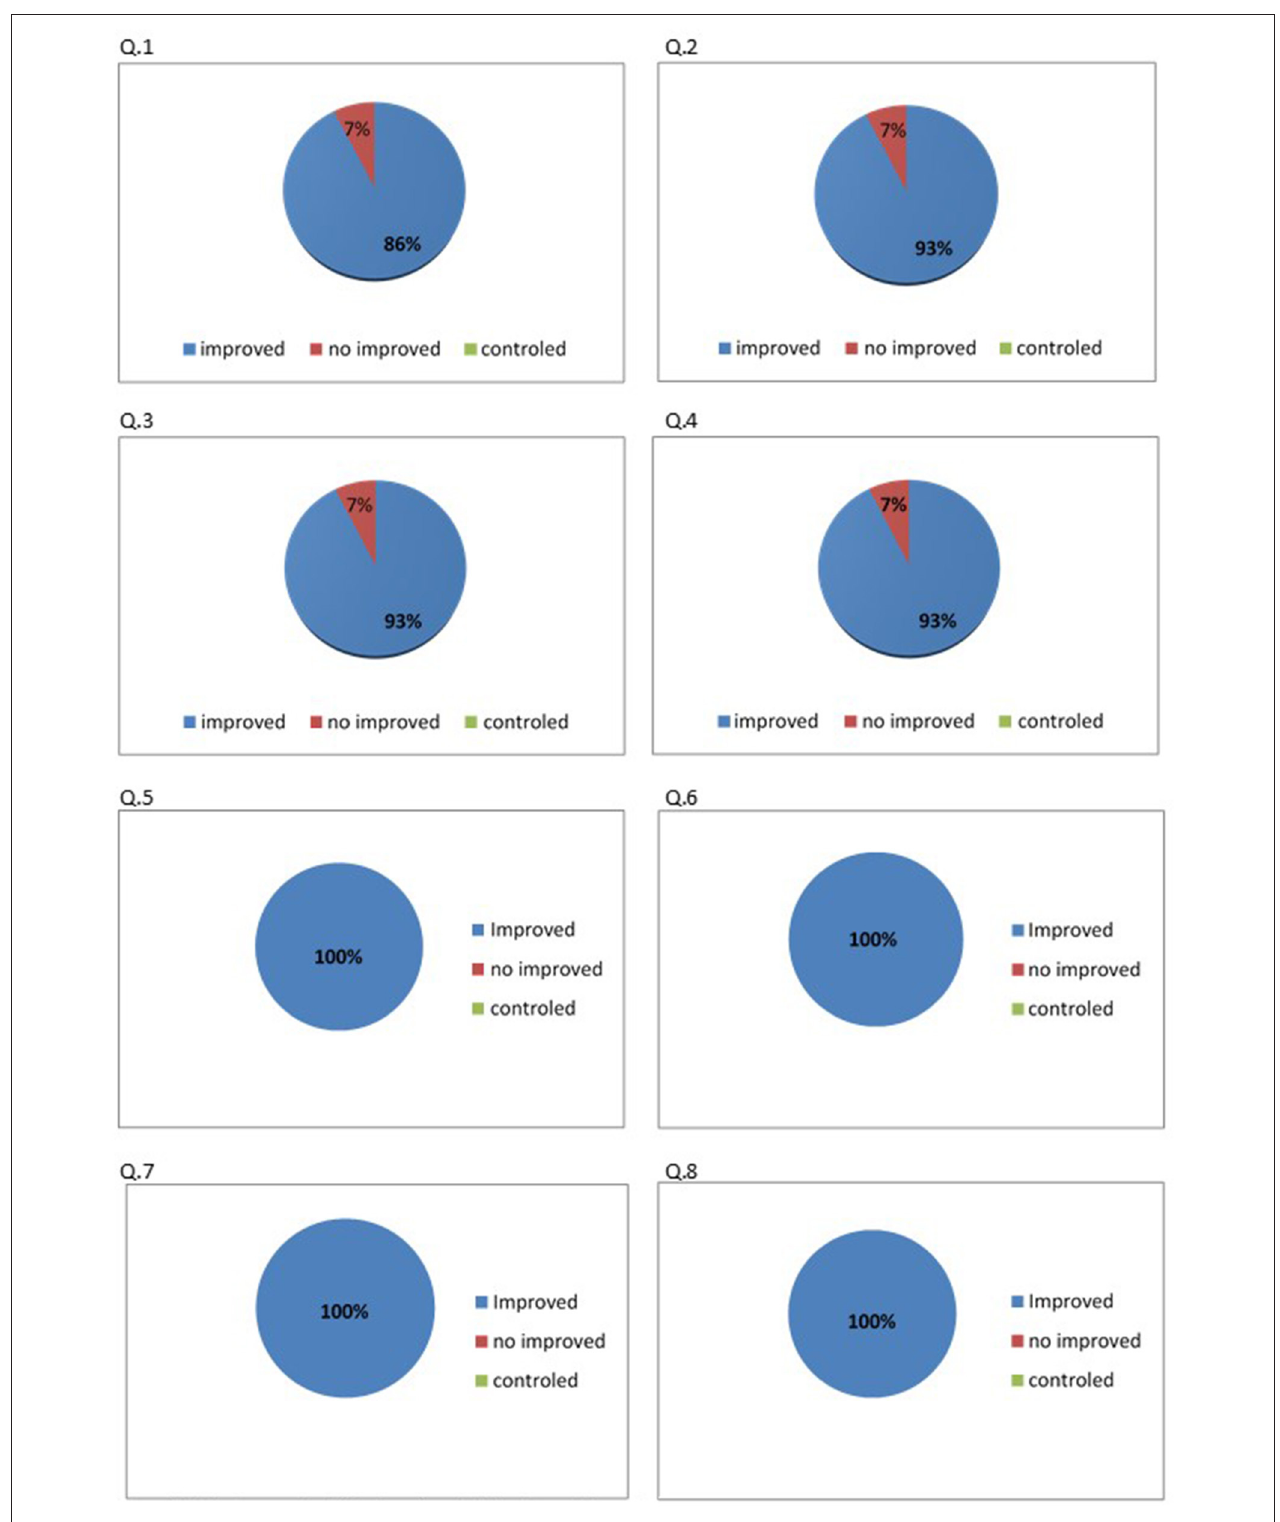
FIGURE 2 | Preliminary results of virtual meetings GNCC-Support. Ferretti et al. (2020).